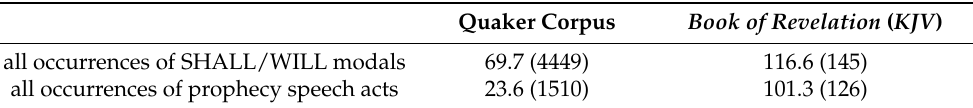
Table 1. Comparison of all ‘foretelling’ instances of SHALL/WILL forms, normed per 10,000 words, actual figures in brackets.